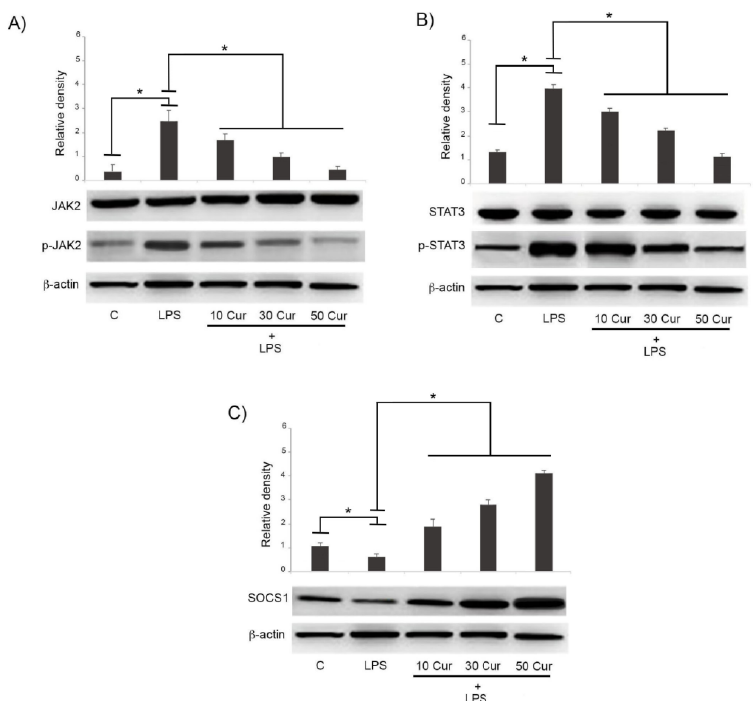
Figure 1. Effect of different concentrations (10, 30, 50  M) of curcumin (Cur) on anti-inflammatory cytokines production in lipopolysaccharide (LPS)-stimulated BV-2 cells. C = controls. ( A ) ELISA assay. Cells were treated with the indicated concentrations of curcumin for 1 h before LPS (1  g/mL) treatment. Supernatants were collected at 24 h after LPS treatment, and the amounts of IL-4 and IL- 10 were measured. ( B ) Reverse transcriptase–polymerase chain reaction (RT-PCR). BV-2 microglial cells were incubated for 6 h with LPS alone or after 1 h of curcumin pretreatment. The experiments were performed in triplicate, and data are expressed as the mean ± SD of five independent experiments. ∗𝑝 < 0.05.